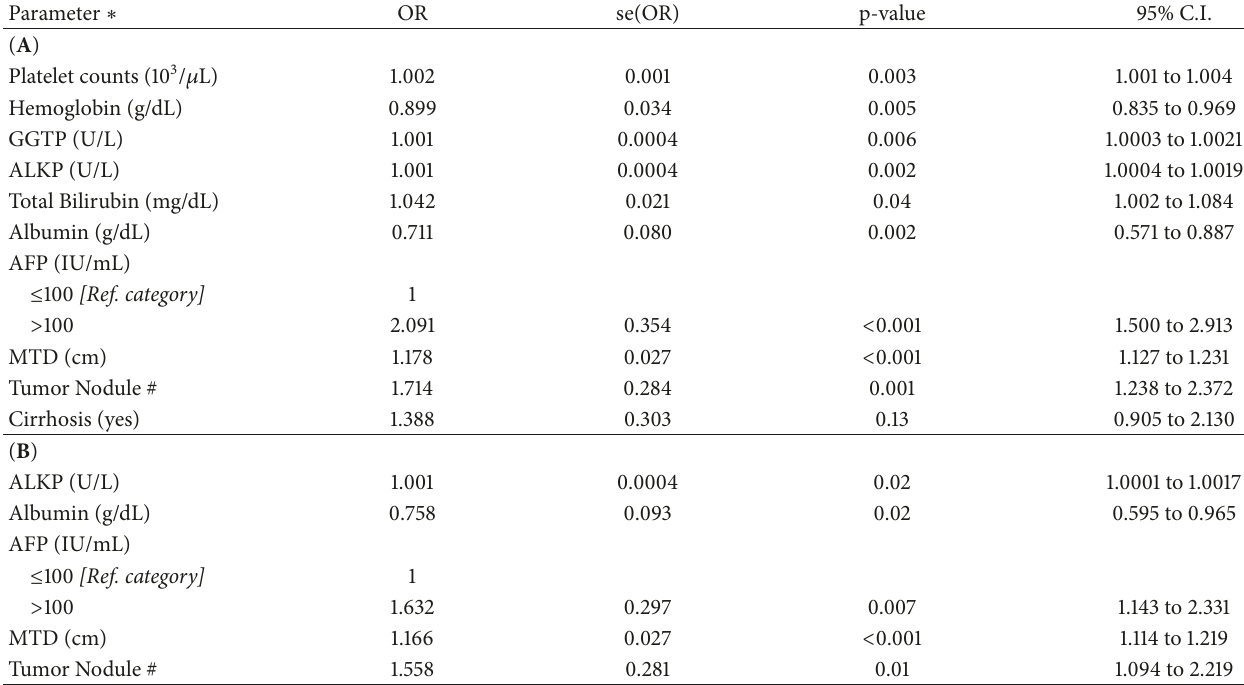
Table 2: Logistic regression model of PVT (No/Yes) , on single variables (A) . Final multiple logistic regression model in stepwise method of